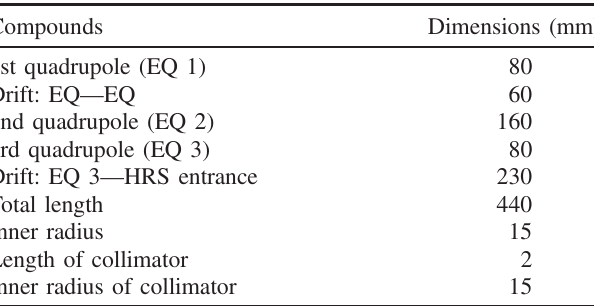
TABLE I. Specification of the electric quadrupole